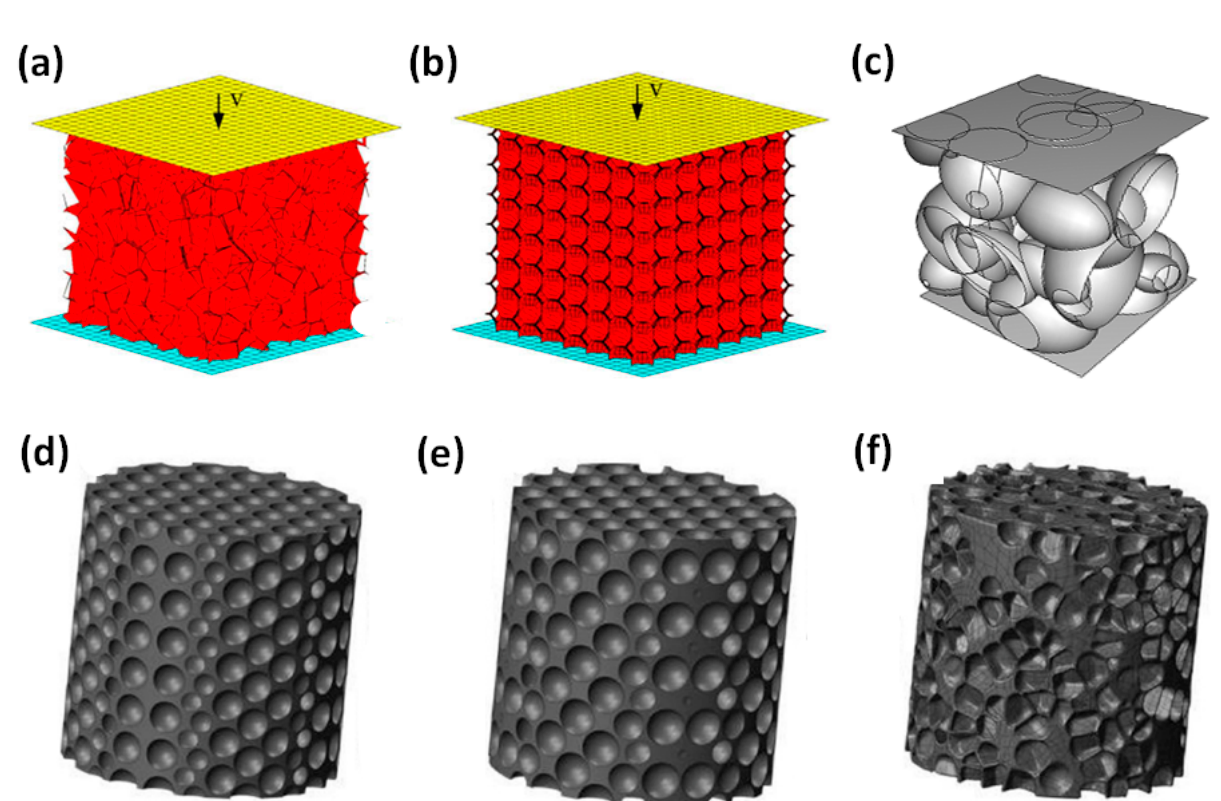
Figure 9. 3D multi-cell models: ( a ) Voronoi model [33]; ( b ) tetradecahedron model [33]; ( c ) ellipsoidal-cell model [113]; ( d ) body-centered cubic (BCC) model [134]; ( e ) face-centered cubic (FCC) model [134]; ( f ) “Ad-hoc” model [134].